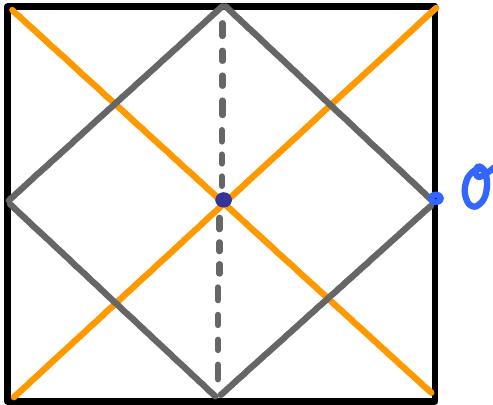
Figure 2 . The Penrose diagram of dS d +1 , with the UV slice w = (cid:25)‘ dS = 2 of the geometry indicated by the dashed grey line. The solid grey lines indicate the two deep IR regions, w = 0 and w = (cid:25)‘ dS . The RT surface S d (cid:0) 1 is in the center of the diagram, indicated as a dark blue point. Its area determines the entanglement entropy between the two matter sectors. and tracing out the second sector gives a maximally mixed density matrix (cid:26) 1 for the (cid:12)rst. It is also the Gibbons-Hawking horizon entropy for an observer momentarily at the deep IR end of the second warped throat at (cid:28) = 0, indicated in light blue. That observer has no interaction with the (cid:12)rst matter sector and must trace it